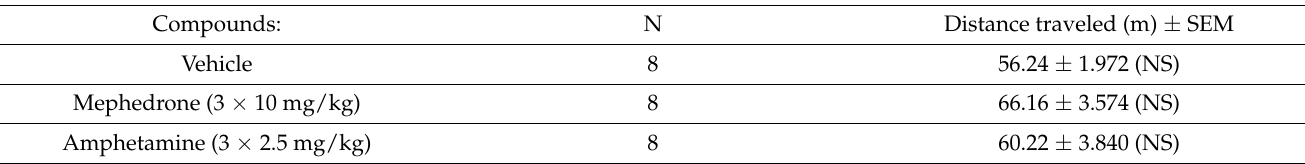
Table 1. Effect of repeated mephedrone or amphetamine administration on locomotor activity. (PND 71) of Barnes Maze Task